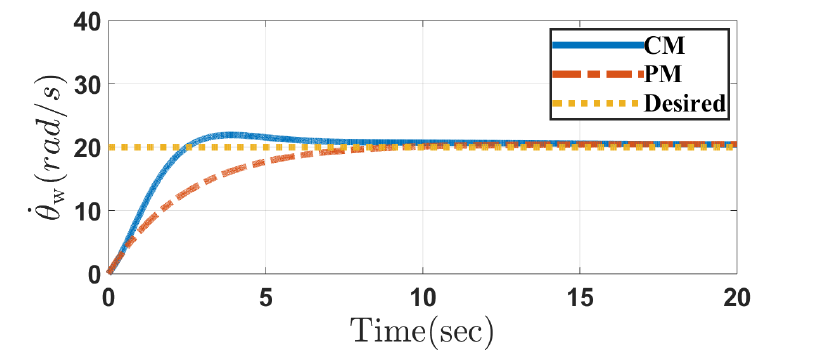
Figure 4. Wheel angular velocity of the system in the conventional method (CM) and the proposed method (PM) in Case